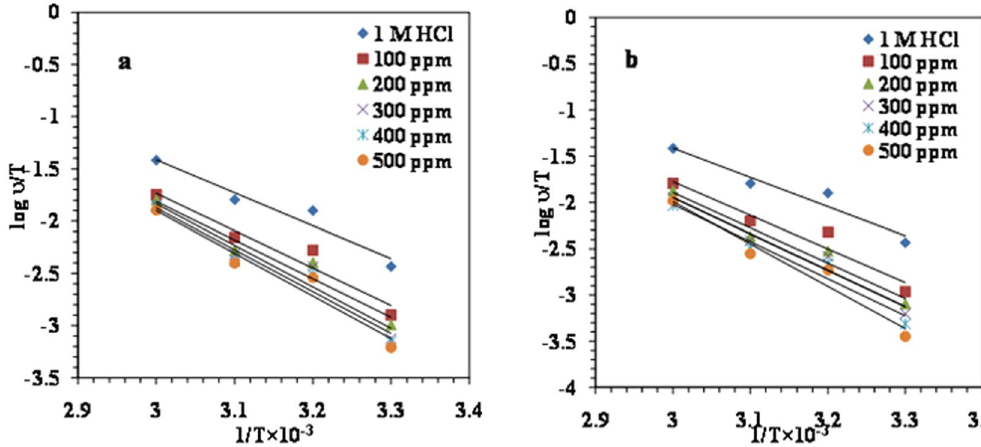
Figure 11. Alternative Arrhenius plots for MS in 1M HCl in the absence and presence of different concentrations of ( a ) LPr and ( b ) LPr + 10 ppm